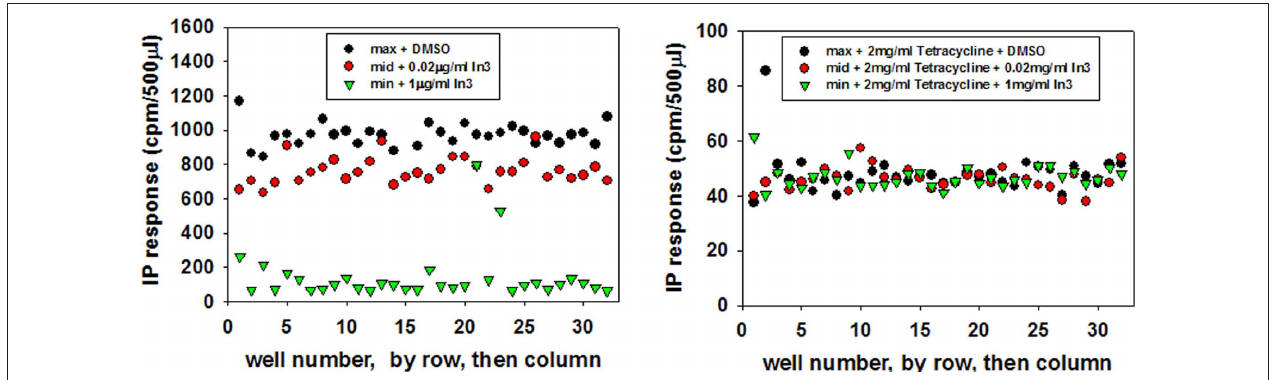
FiGurE 3 | Well-by-well iP stimulation in response to a GnrH agonist, following rescue of mutant E 90 K by maximum, EC Data is graphed by row, then column. The upper graphic shows the absence of tetracycline; the lower graphic shows the presence of tetracycline. Note that the y -axis